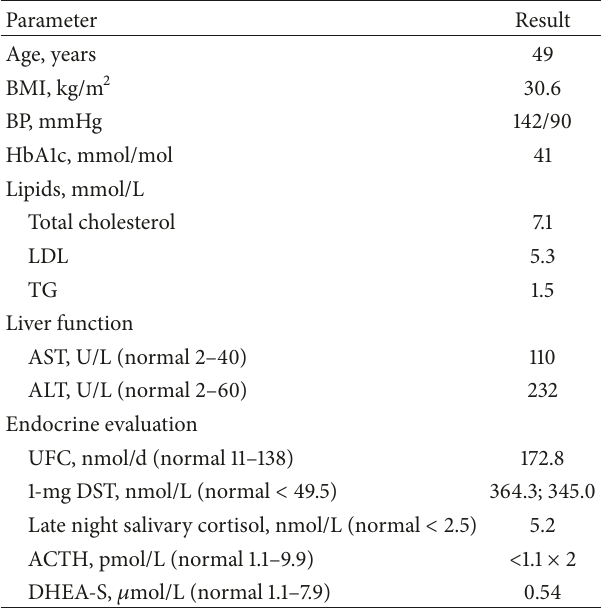
Table 1: Baseline patient characteristics and laboratory